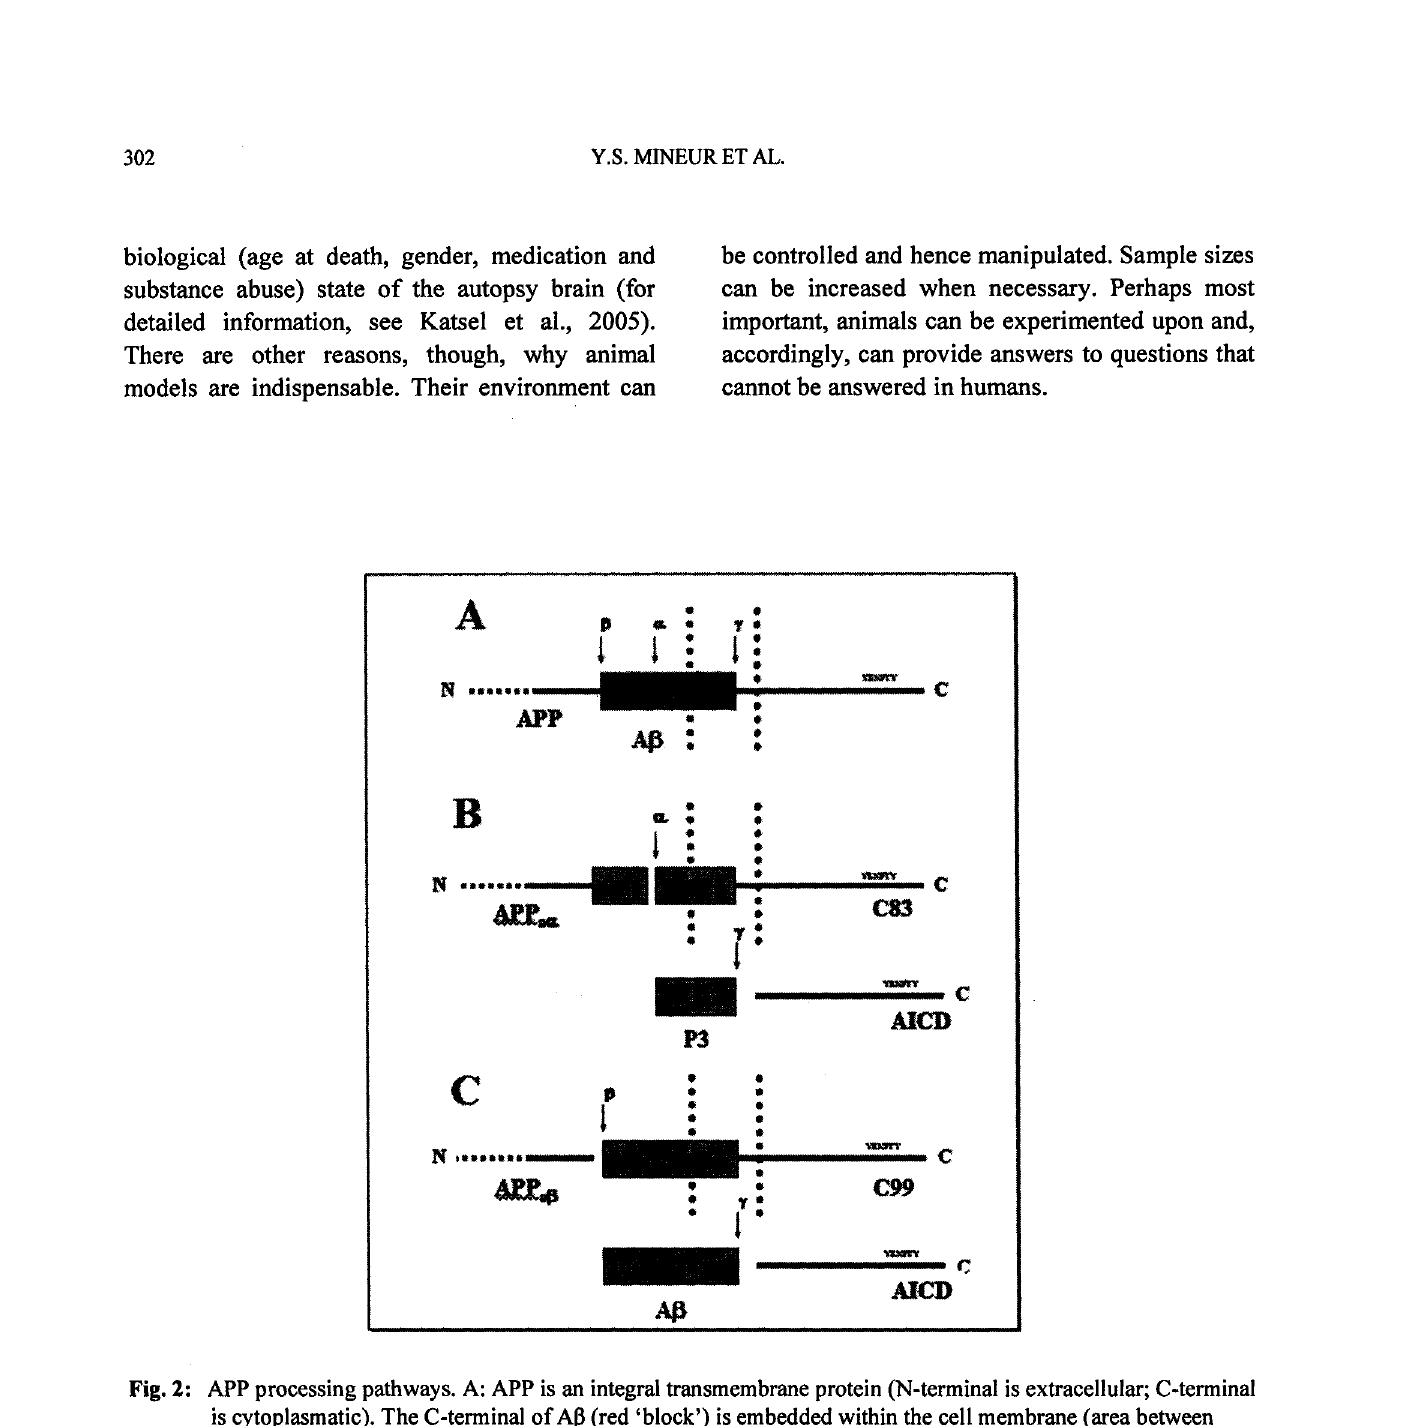
Fig. 2: APP processing pathways. A: APP is an integral transmembrane protein (N-terminal is extracellular; C-terminal is cytoplasmatic). The C-terminal of AI3 (red ’block’) is embedded within the cell membrane (area between dashed lines). B: Non-amyloidogenic pathway. APP is cleaved by the membrane-associated metalloprotease a- secretase within the AI3 domain, thereby preventing the formation of AI3. This results in the release of the large soluble extracellular N-terminal portion ofAPP (APPsa) and C83 (C-terminal fragment of 83 residues). C83 might be further processed by ),-secretase to release the p3 peptide, which is considered non-amyloidogenic, and the APP intracellular domain (AICD). C: Amyloidogenic pathway. APP is cleaved by two distinct proteases: 13- and ),-secretase. First, 13-Secretase, (BACE1 13-site APP-cleaving enzyme) cleaves APP at the N- terminal region of the AI3 sequence, resulting in the soluble APPsl3 and the amyloidogenic C99 (C-terminal fragment of 99 residues). Second, y-secretase cleaves C99, resulting in AICD and